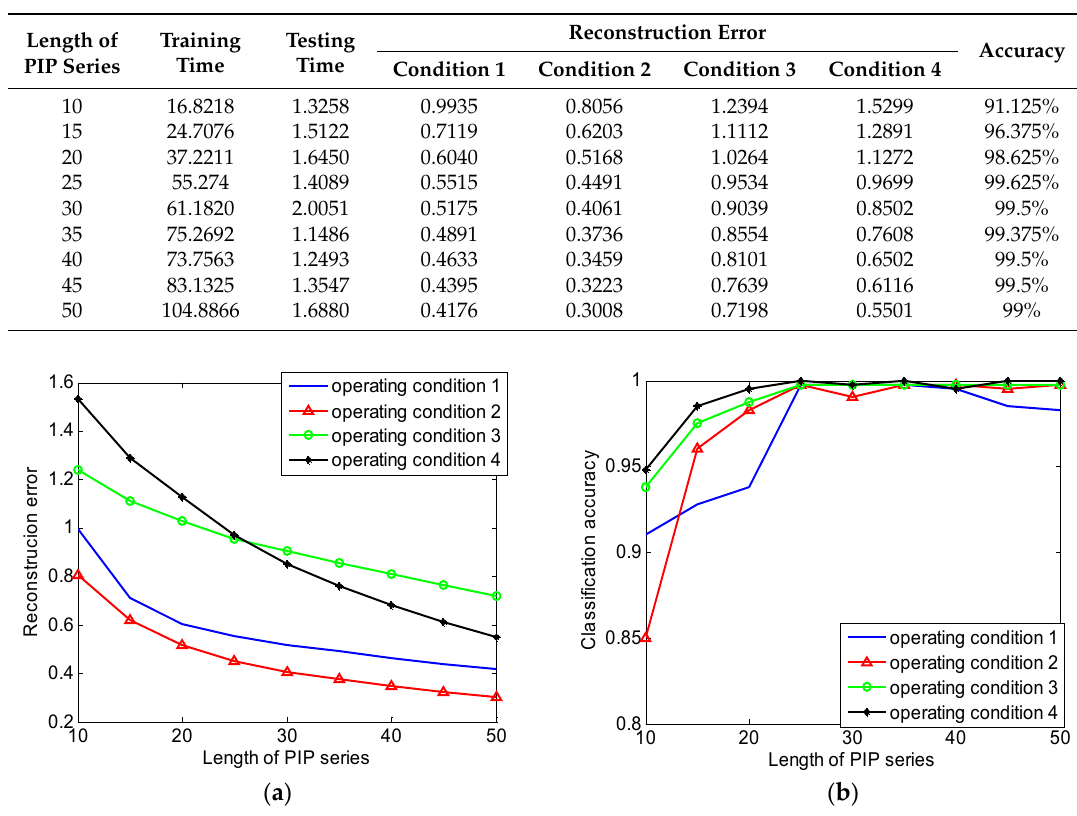
Table 7. Model’s property with different length of PIP series (seven symbols).